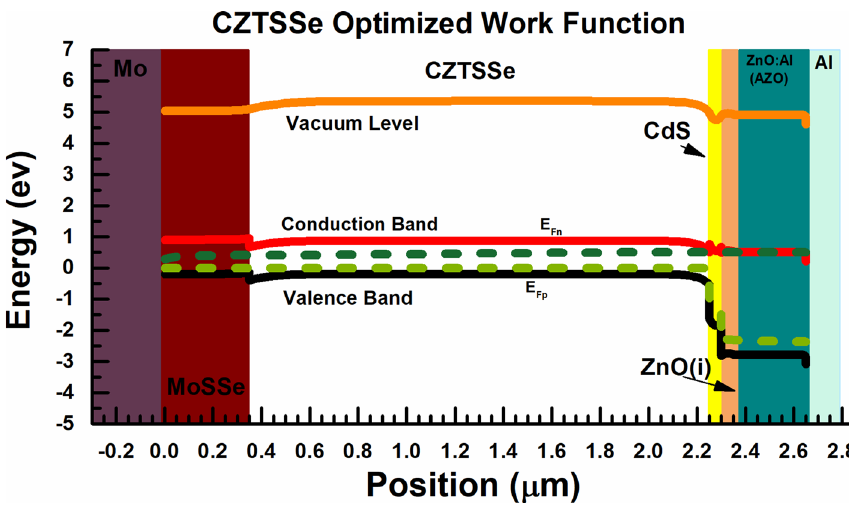
Figure 5. Band diagram of CZTSSe solar cell with optimized value of the work function.